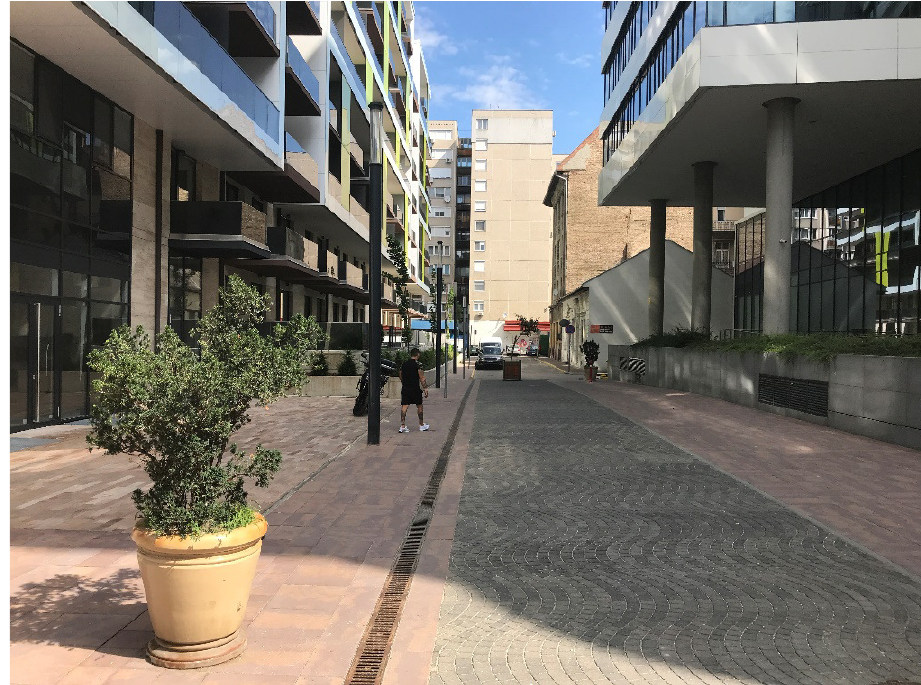
Figure 4. Urban diversity of the Szigony area: New residential buildings, prefabricated modern slabs, and historic tene‐ ments in the